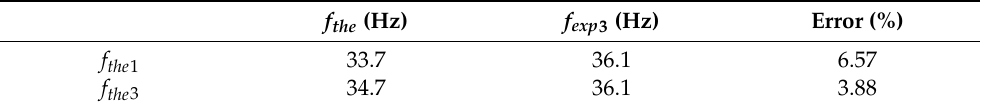
Figure 11. Frequency response of the system during the acceleration process. Table 5. Theoretical and experimental results of system frequency during the acceleration process.